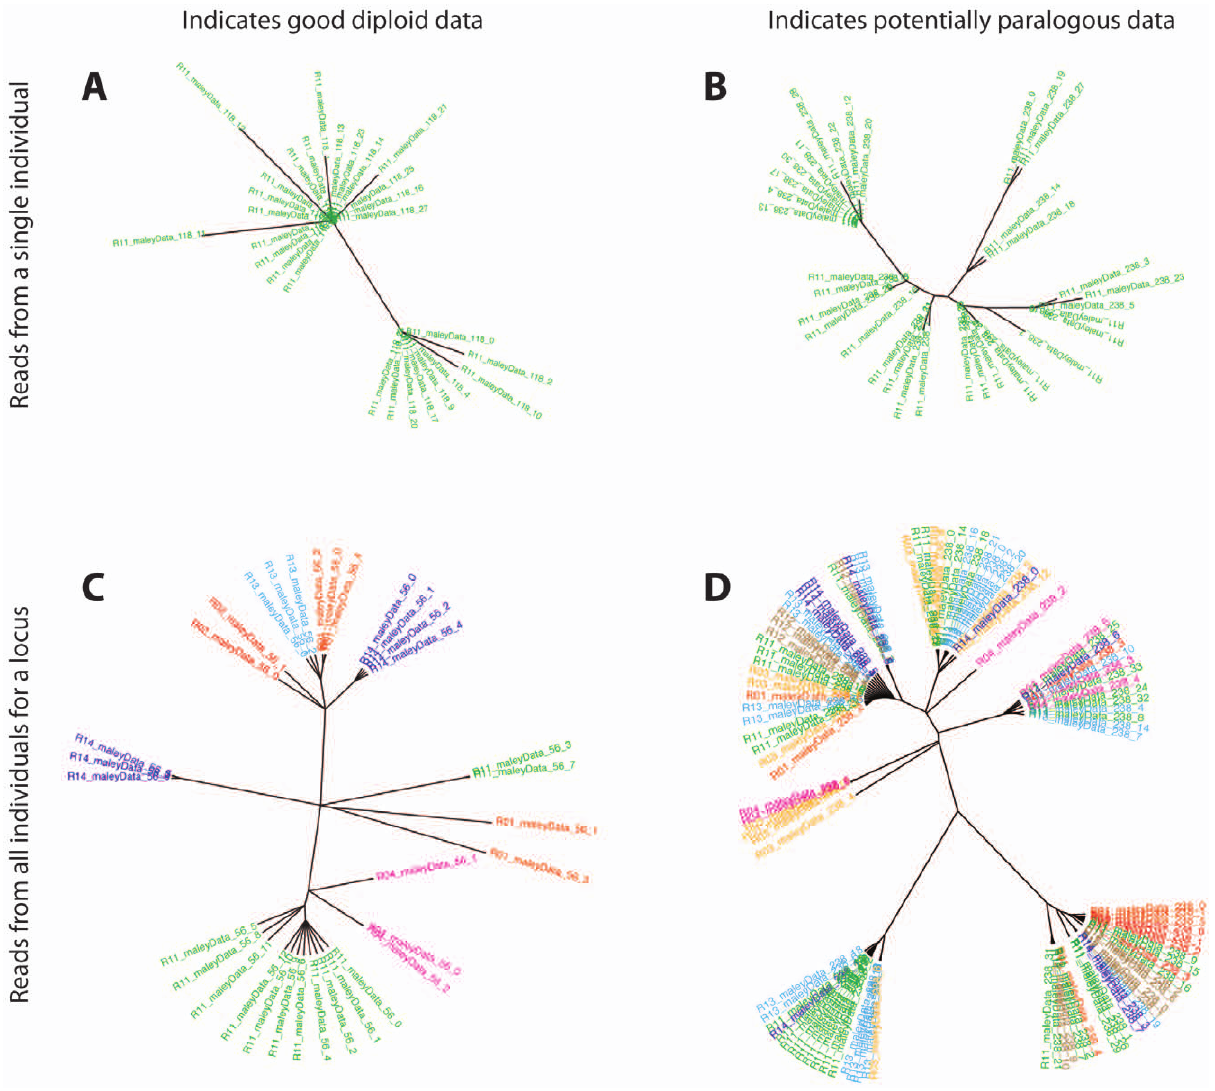
Figure 5. Neighbor-joining trees of aligned reads (reads output from the program) to help assess copy number. Shown are reads from one individual ( A , B ) and all the reads for a locus ( C , D ). Both ( A ) and ( C ) imply single copy loci; in ( A ) there are only two major clades and in ( C ) the reads for each individual, as shown by the different colors, belong to two clades at the most. Both ( B ) and ( D ) indicate potential multi-copy loci; in (B), there are greater than two clades and in ( D ) the reads for each individual, as shown by the different colors, are frequently distributed across greater than two clades.